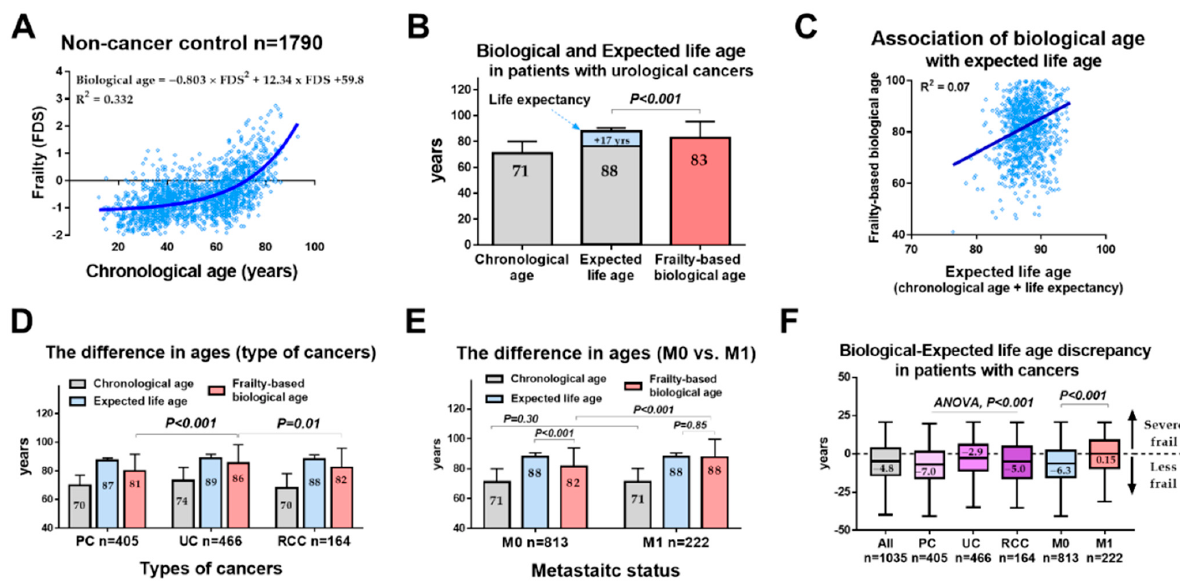
Figure 2. Primary outcomes. ( A ) The estimation of frailty-based biological ages using the frailty-discriminant score (FDS) from noncancer individuals. ( B ) The evaluation of the chronological, frailty-based biological, and expected life ages. ( C ) The association of frailty-based biological age and expected life age in patients with urological cancers. ( D ) The comparison of three types of ages among PC, UC, and RCC patients. ( E ) The comparison between three types of ages between the nonmetastatic (M0) and metastatic (M1) disease groups. ( F ) Estimation of the age discrepancy between the frailty-based biological age and expected life age.